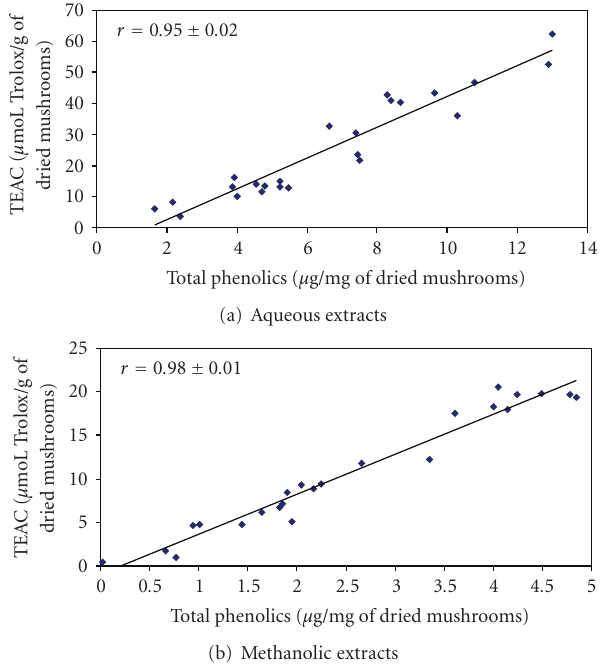
Figure 1: The correlation between the concentration of phenolic compounds and Trolox equivalent antioxidant capacity. The Pear- son correlation coe ffi cient between Trolox equivalent antioxidant capacity and total concentration of phenolics was calculated and tested with Student’s t -test. The linear regression was determined with the least-squares